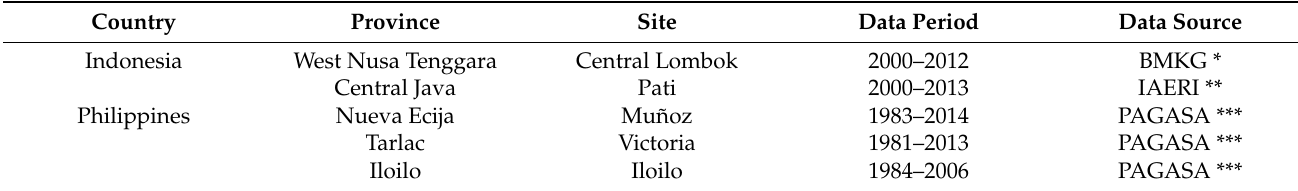
Table 2. Observed historical weather data used in the